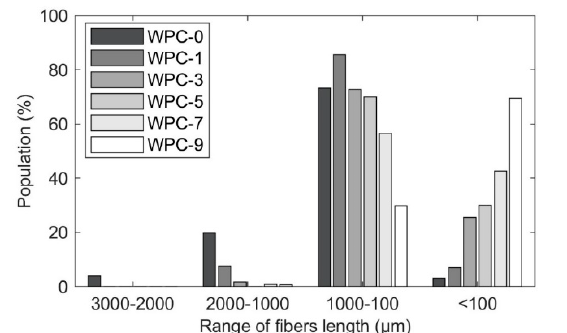
Figure 2. Fiber length distribution. Compacted-thermomechanical pulp (TMP) fibers extracted via Soxhlet from wood-fiber thermoplastic composites (WPCs).